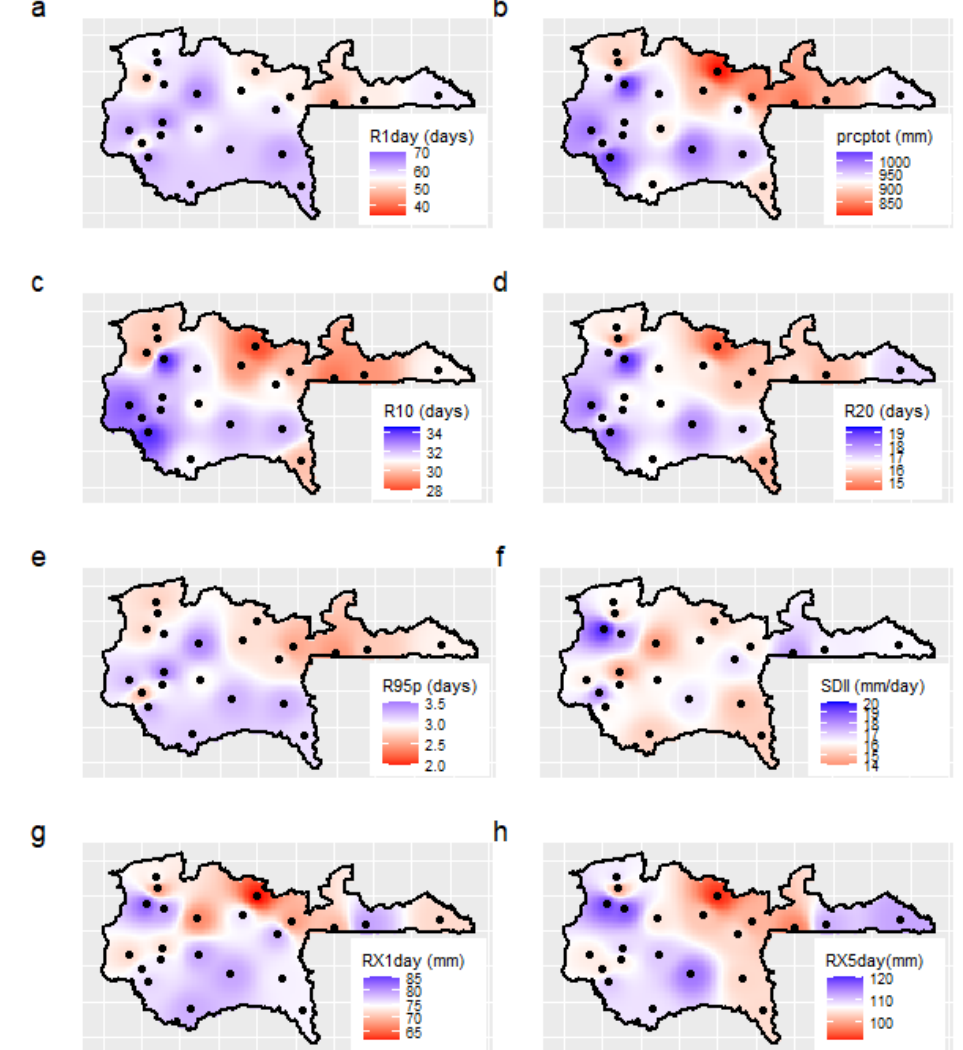
Figure 2. Distribution rainfall indices given as the climatological average of R1day ( a ), PRCPTOT ( b ), R10 ( c ), R20 ( d ), R95p ( e ), SDII ( f ), RX1day ( g ), and RX5day ( h ) distributed over the study area. Circles denote climate stations. The blue (respectively red color) represents the areas with the index value higher (respectively lower) than the climatological average of the study area and the white color corresponds to the value close to the climatological average of rainfall indices. Maps are obtained by interpolating station values using the IDW method.